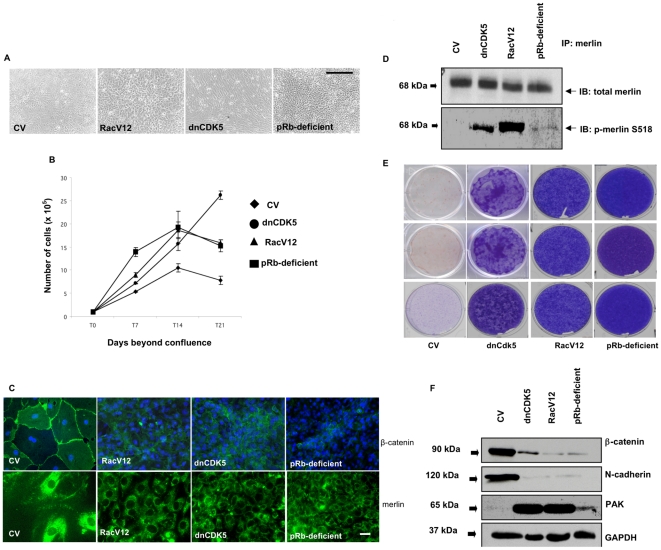
Unrestrained Rac 1 activation in pRb-expressing osteoblasts mimics pRb loss by perturbing cell adhesion.Phase contrast photomicrographs at x10 (A) and growth curves (B) showing that pRb-expressing MC3T3 osteoblasts stably expressing RacV12 or dnCdk5 grow in culture to a higher density relative to pRb-expressing MC3T3 osteoblasts transfected with control vector (CV). Bar in (A)  =  20 µm. Each point in (B) represents the mean of 3 independent experiments ± SEM. (C) Immunocytochemical analysis showing loss of membrane-associated β-catenin (top) and merlin (bottom) in pRb-expressing MC3T3 osteoblasts transfected with either RacV12 or dnCdk5, as compared to CV-transfected cells. These cells show a staining pattern comparable to that observed in pRb-deficient MC3T3 osteoblasts (last panel to the right). Magnification = ×100. Bar = 1 µm. (D) Merlin was immunoprecipitated from whole protein lysates with a merlin-specific antibody followed by immunoblots with a merlin phospho-specific antibody recognizing Ser518. Merlin phosphorylation was observed in pRb-expressing osteoblasts cells transfected with dnCdk5 or Rac V12, as well as in pRb-deficient osteoblasts. (E) Triplicates of crystal violet-stained plates showing foci formation in pRb-expressing osteoblasts transfected with dnCdk5 5 or RacV12 and in untransfected pRb-deficient osteoblasts, as compared with CV-transfected cells. (F) Immunoblots showing decreased expression of β-catenin and N-cadherin, and increased Pak1 expression in pRb-expressing osteoblasts transfected with dnCdk5 or RacV12, as well as in untransfected pRb-deficient osteoblasts, relative to CV-transfected cells. Experiments were conducted in osteoblasts cultured until 14 dbc.